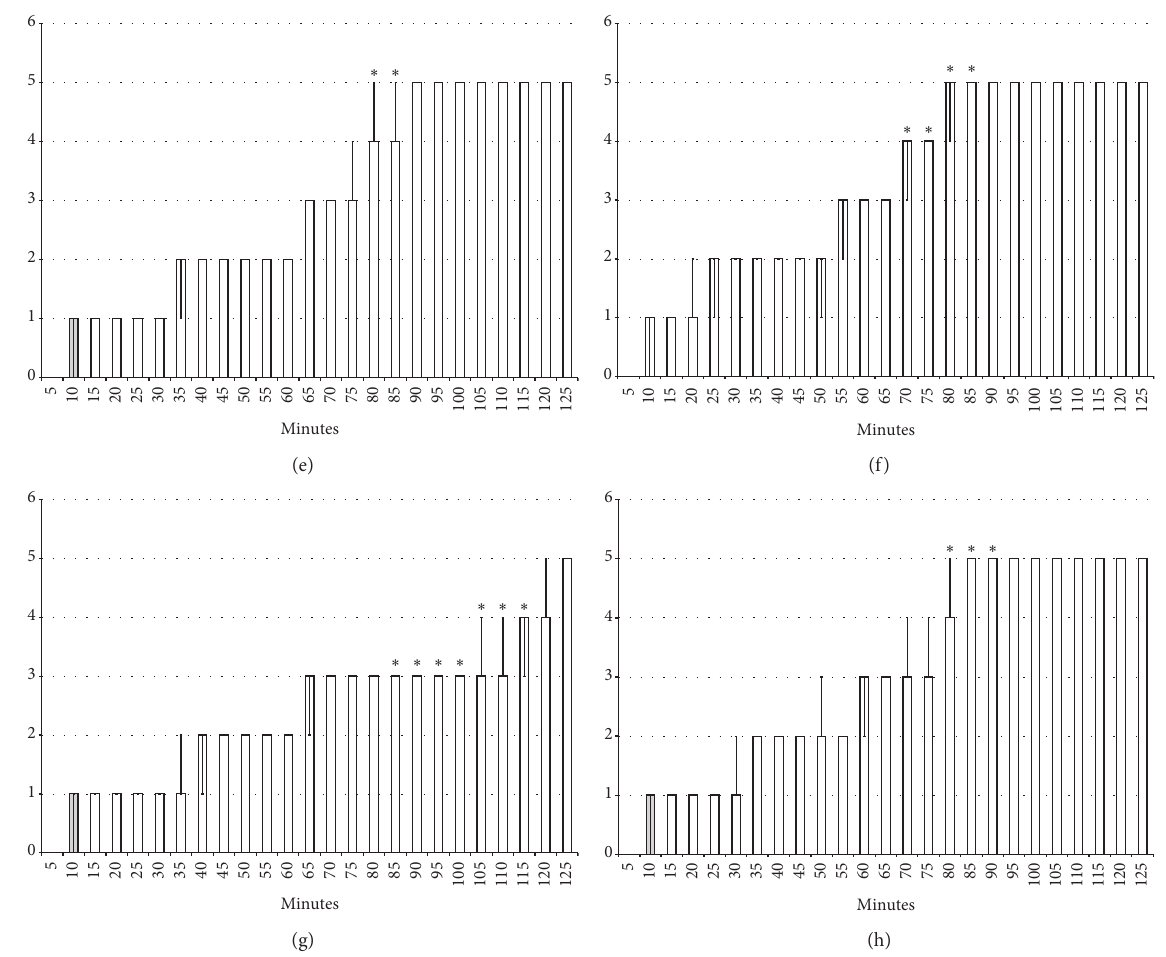
Figure 5: Axillary block (function failure): left brachial plexus perineural anesthesia (white bars) produced considerable and long-lasting function failure of the affected fore limb and an inability to walk and to grasp. Therapy effect of the agents (saline 5ml/kg, BPC 15710 μ g/kg, L-NAME 5mg/kg, and L-arginine 100mg/kg intraperitoneally, alone and/or together) given later at 10 minutes after lidocaine (gray bars indicate presentation at 10min lidocaine-time). Perineural anesthesia of the nerves of the left brachial plexus, scored 0–5. (a) Saline (control). (b) L-NAME+L-arginine. (c) BPC 157. (d) L-NAME+BPC 157. (e) L-NAME. (f) L-NAME+BPC 157. (g) L-arginine. (h) L- NAME+L-arginine +BPC 157. Values are presented as min/med/max. ∗ P < 0 . 05 at least vs.